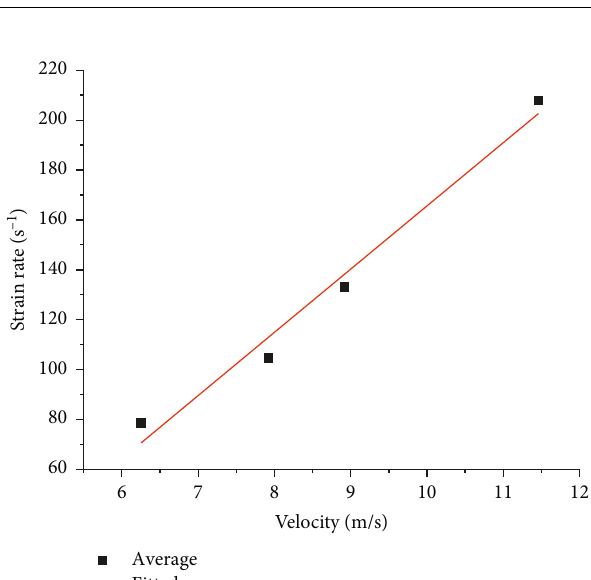
Figure 10: Typical curves of different DIF models compared with test values. Table 4: Coefficients in the fitting formula of DIF and lg _ ε